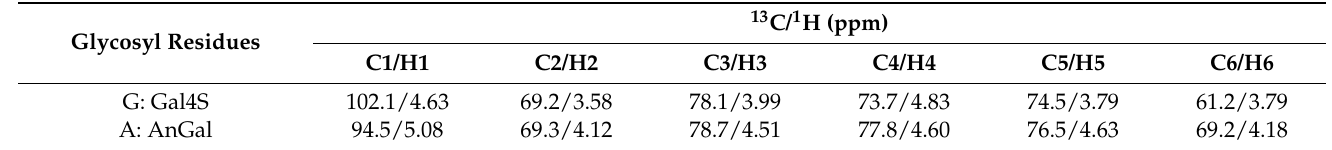
Table 1. 1 H and 13 C NMR chemical shifts of DC-6 in D 2 O.